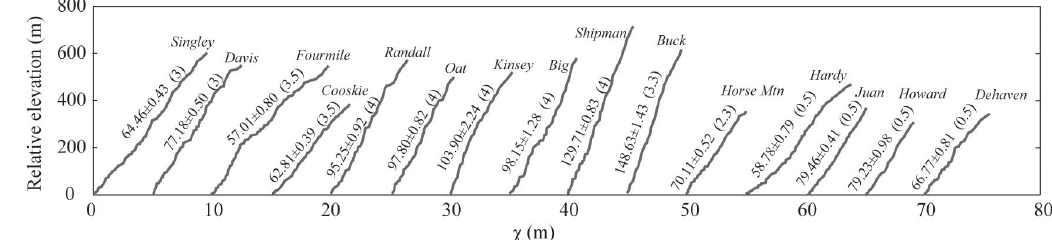
Figure 6. χ − z plots of the streams (bedrock channels) based on the mean concavity (0.45). Numbers are normalized channel steepness, k sn , with the uncertainty estimates. Numbers in the parentheses are uplift rates, in units of millimeters per year (Snyder et al., 2000).